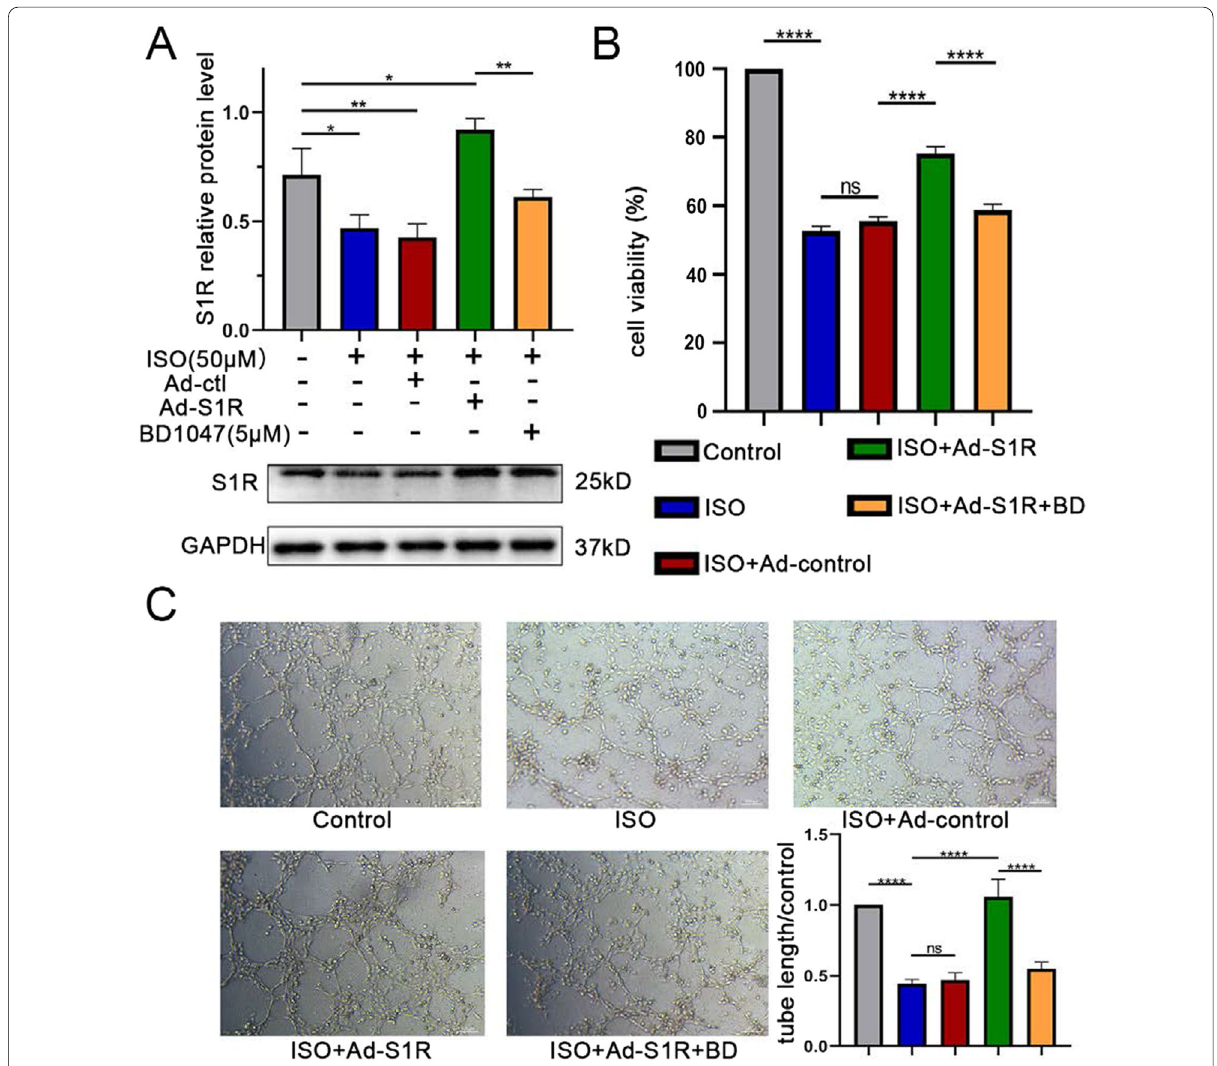
Fig. 5 Transfection of Ad-S1R promoted angiogenesis of HUVECs. A Western blot results showed that transfection of AAV-S1R upregulated the sigma-1 receptor expression. N 3 for quantified analysis; B Ad-S1R transfected enhanced proliferation of HUVECs, confirmed by CCK-8 experiment; = C Ad-S1R transfected HUVECs accelerated tube formation. *P < 0.05; **P < 0.01; ***P < 0.005; ****P <